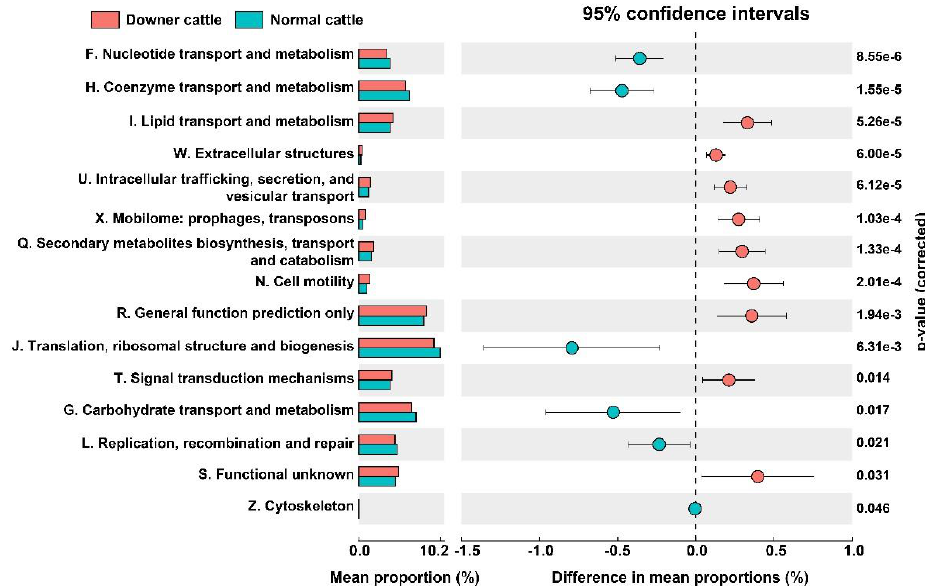
Figure 4. Functional gene prediction of brain microbiota from downer and normal cattle. The COG categories mentioned in the figure are statistically significant ( p < 0.05). The mean portion was illustrated as a bar chart based on the detected COG IDs corresponding to its COG categories. The mean proportions, sphere, and error bar indicate mean and standard deviation, respectively. The corrected p -value was mentioned on the right.